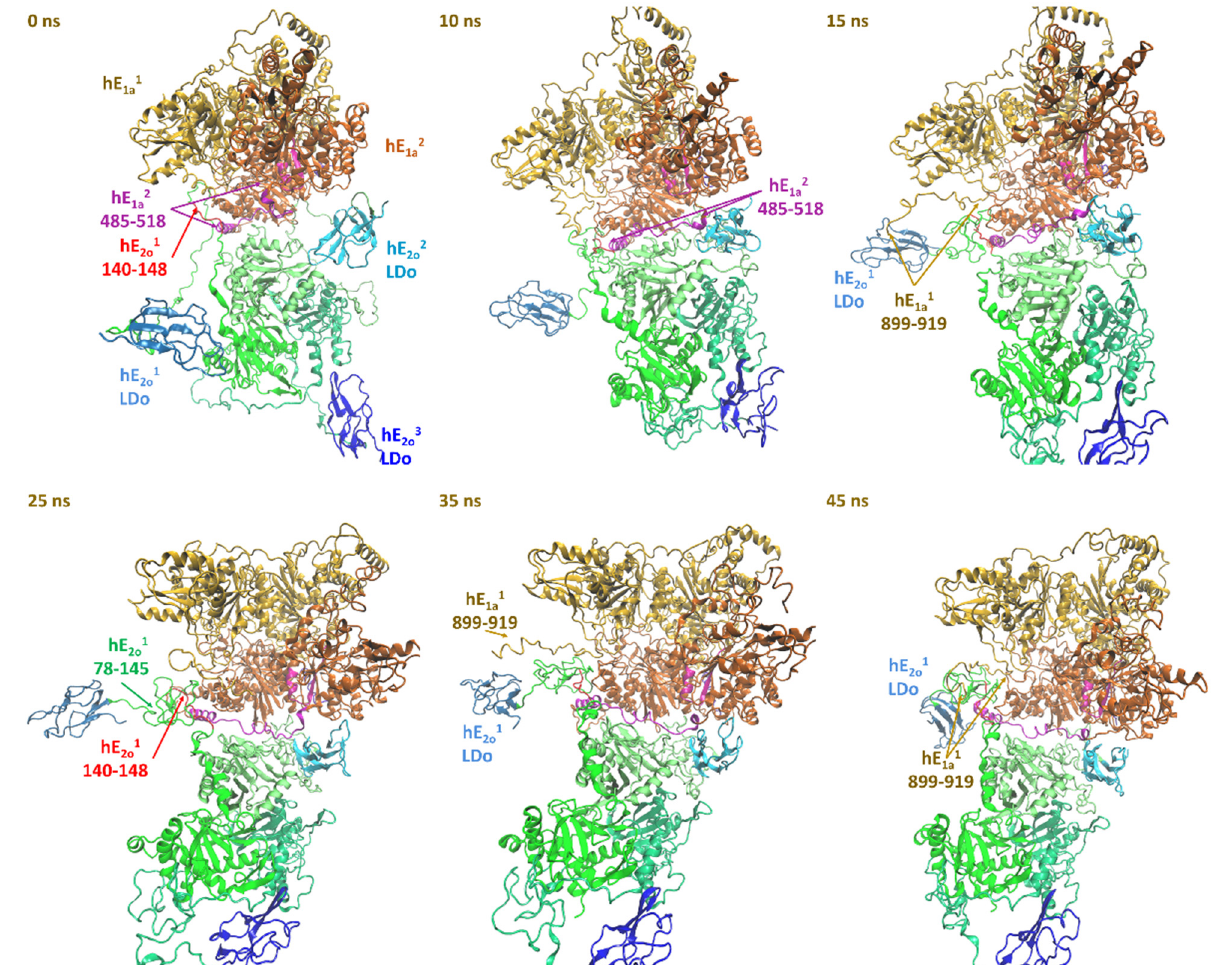
Figure 4. Selected time points along the MD simulation of the subcomplex built from a hE1a dimer and hE2o trimer illustrating the motions of an unbound LDo. In this figure, the hE2o trimer has an LDo bound to hE1a (hE2o 2 LDo), whereas another LDo migrates towards hE1a. Notable regions are the region of the hE1a linker domain (485–518), which will have interactions with two hE2o monomers, hE1a 140–148 (similar to hE1o 188–196) in the N-terminal region, which will interact with hE2o 78–145. The C-terminal region of hE1a is, in part of the time, proximal to the N-terminal region of hE2o, which also explains the observed cross-links between them. hE1a residues 899–919 (955–975 in hE1o) appear to play a—yet unrevealed—role in the subunit dynamics of this subcomplex. Although the hE2o trimer has three lipoyl domains (LDo), they are not all needed